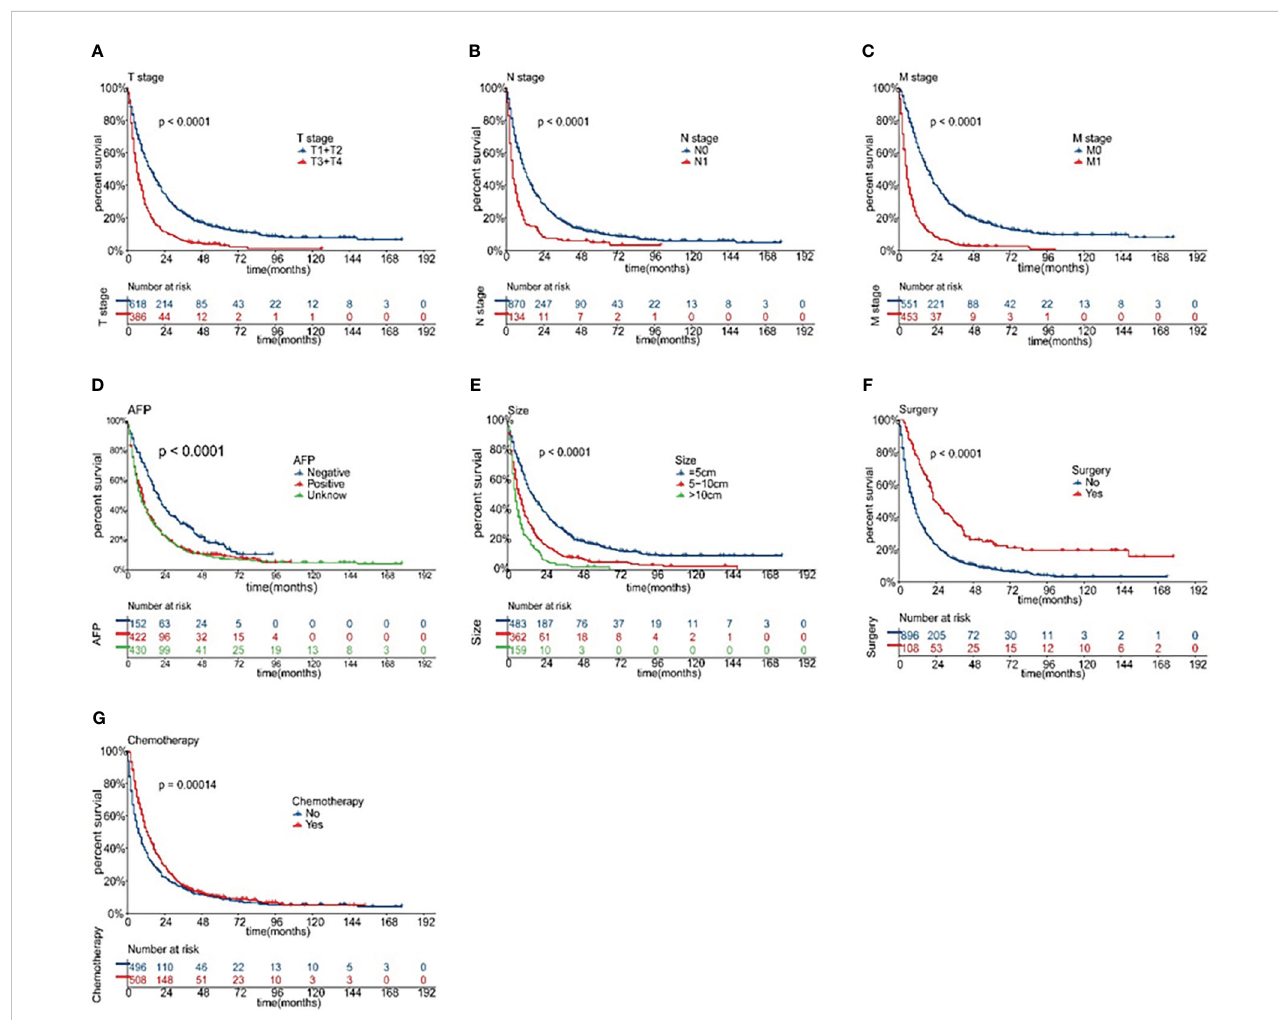
FIGURE 2 The Kaplan-Meier survival analysis curves for OS rates according to various independent risk factors: T stage (A) , N stage (B) , M stage (C) , AFP (D) , tumor size (E) , surgery (F) , and chemotherapy (G)